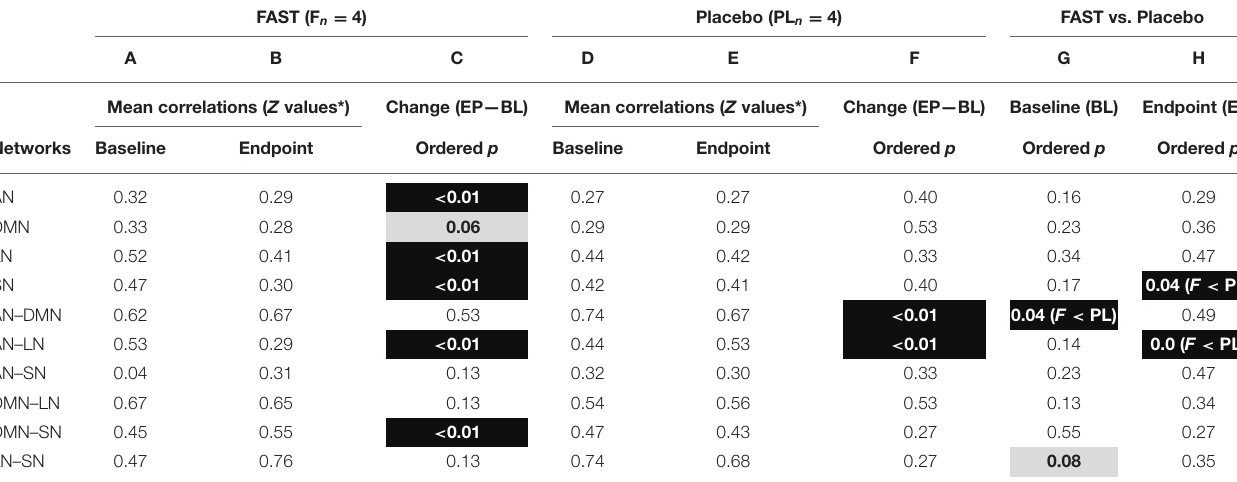
TABLE 2 | Resting state functional connectivity within and between networks: pilot study imaging subgroup FAST and placebo participants. FAST (F n = 4) Placebo (PL n = 4) FAST vs.